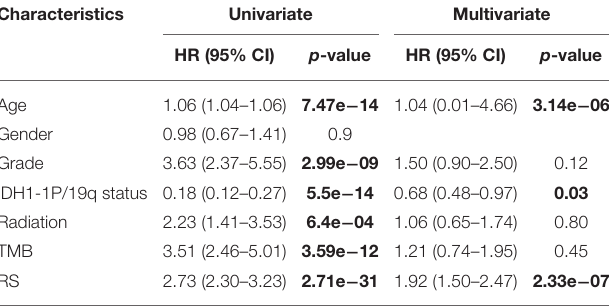
TABLE 2 | Univariate and multivariate Cox regression analysis in TCGA. Characteristics Univariate